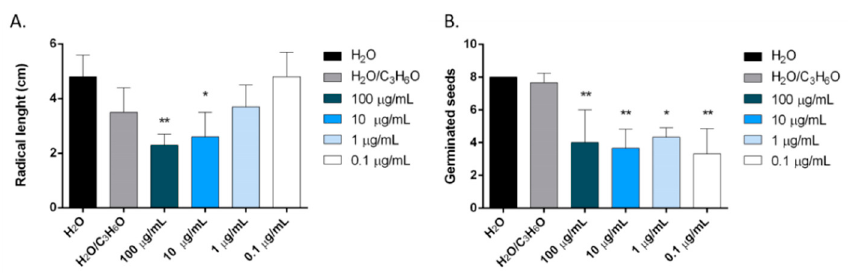
Figure 11. Phytotoxic activity of O. majorana essential oil against radical elongation of L. sativum ( A ) and against germination of L. sativa ( B ) seeds. Results are expressed as the mean of three experiments standard deviation. * p < 0.05, ** p < 0.01 compared to control (ANOVA followed by Dunnett’s multiple comparison test).